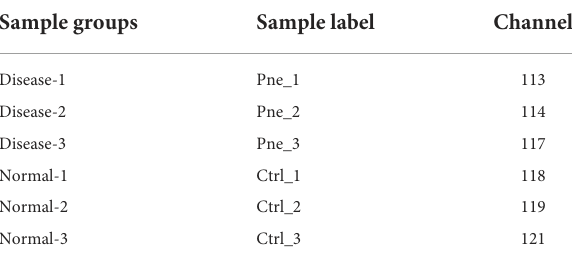
TABLE 1 Sample-corresponding iTRAQ